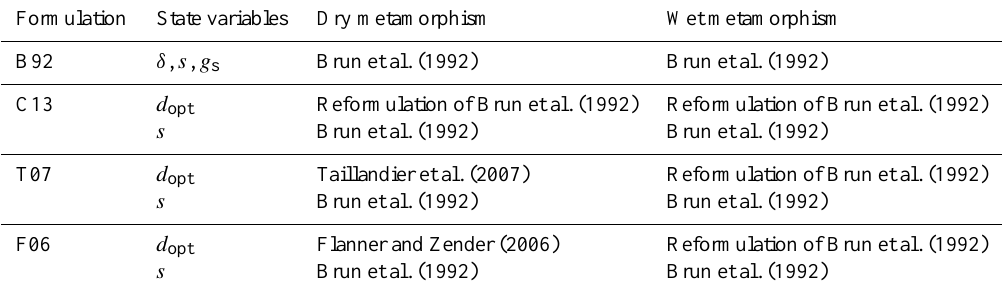
Table 1. Metamorphism formulations implemented in Crocus. B92 (Brun et al., 1992) describes snow grains in terms of dendricity ( δ ), sphericity ( s ) and size ( g s ). C13 (this work), T07 (Taillandier et al., 2007) and F06 (Flanner and Zender, 2006) use optical diameter ( d opt ) and s . See text for more details.